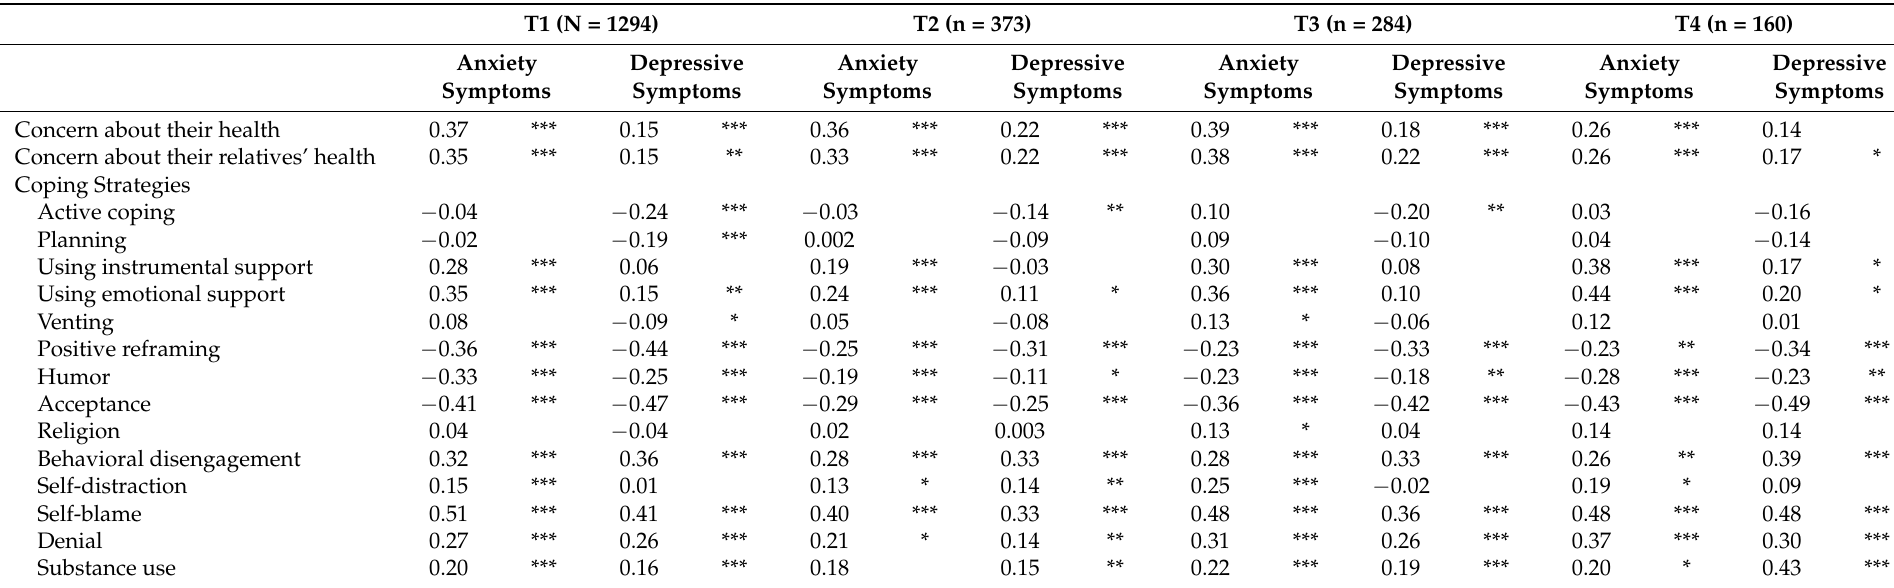
Table 4. Spearman correlations between anxiety and depressive symptoms, concerns about health (own and relatives’) and coping strategies at each timepoint.